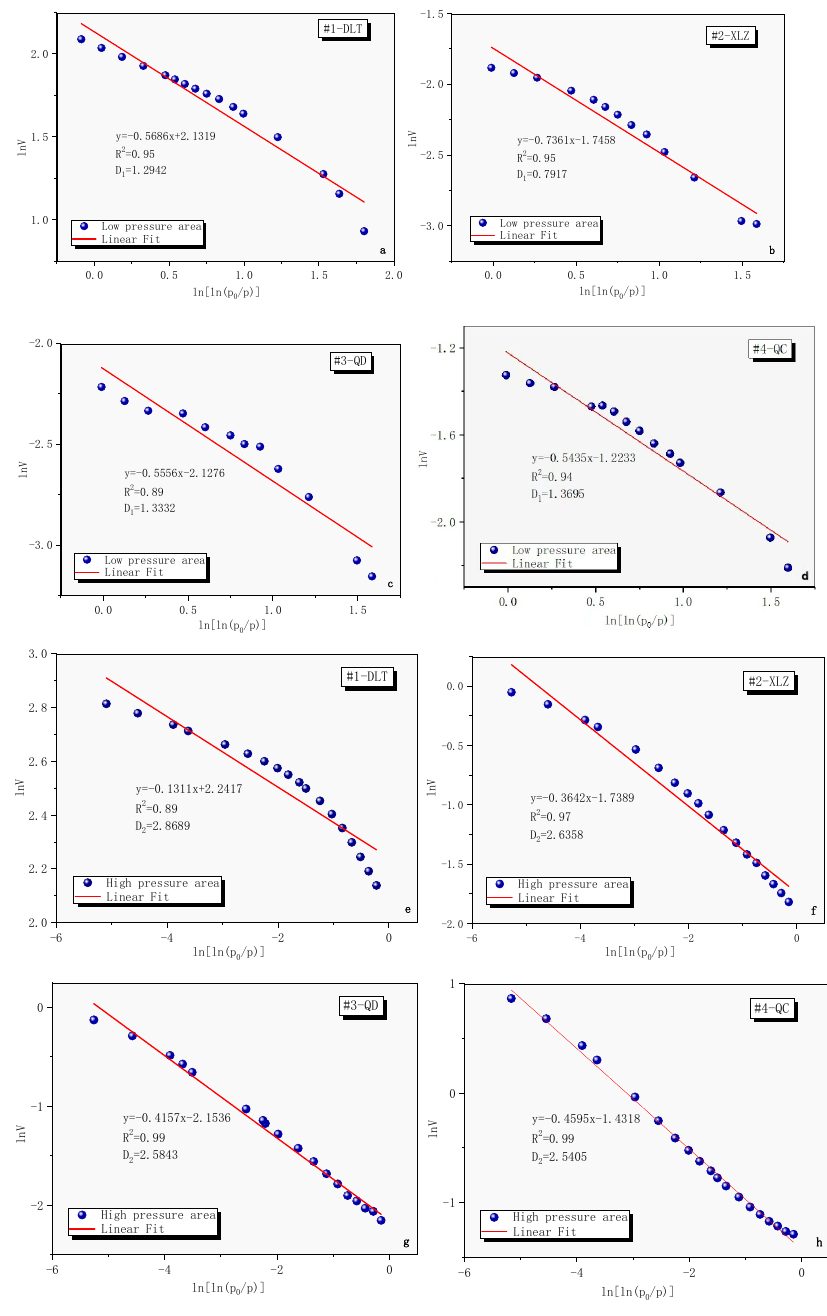
Figure 5. Fitting diagrams of 𝑙𝑛(𝑉/𝑉0) and 𝑙𝑛[𝑙𝑛 (𝑝 (cid:2868) /𝑝)] .